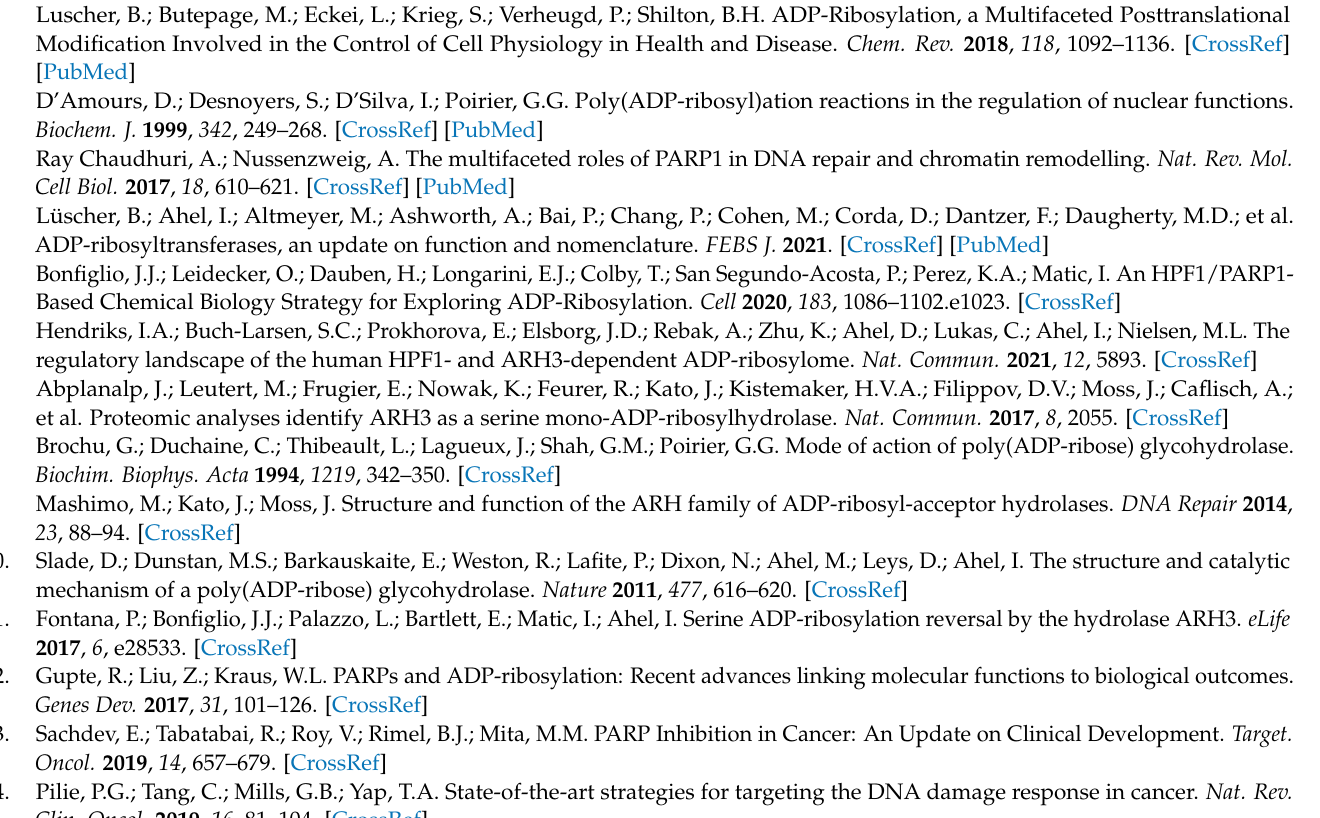
Table S1. Overview of ADPr sites. A list of all 1681 human ADPr sites identified in this study; Table S2. Overview of ADPr-modified proteins. A list of 695 human ADPr-modified proteins identified in this